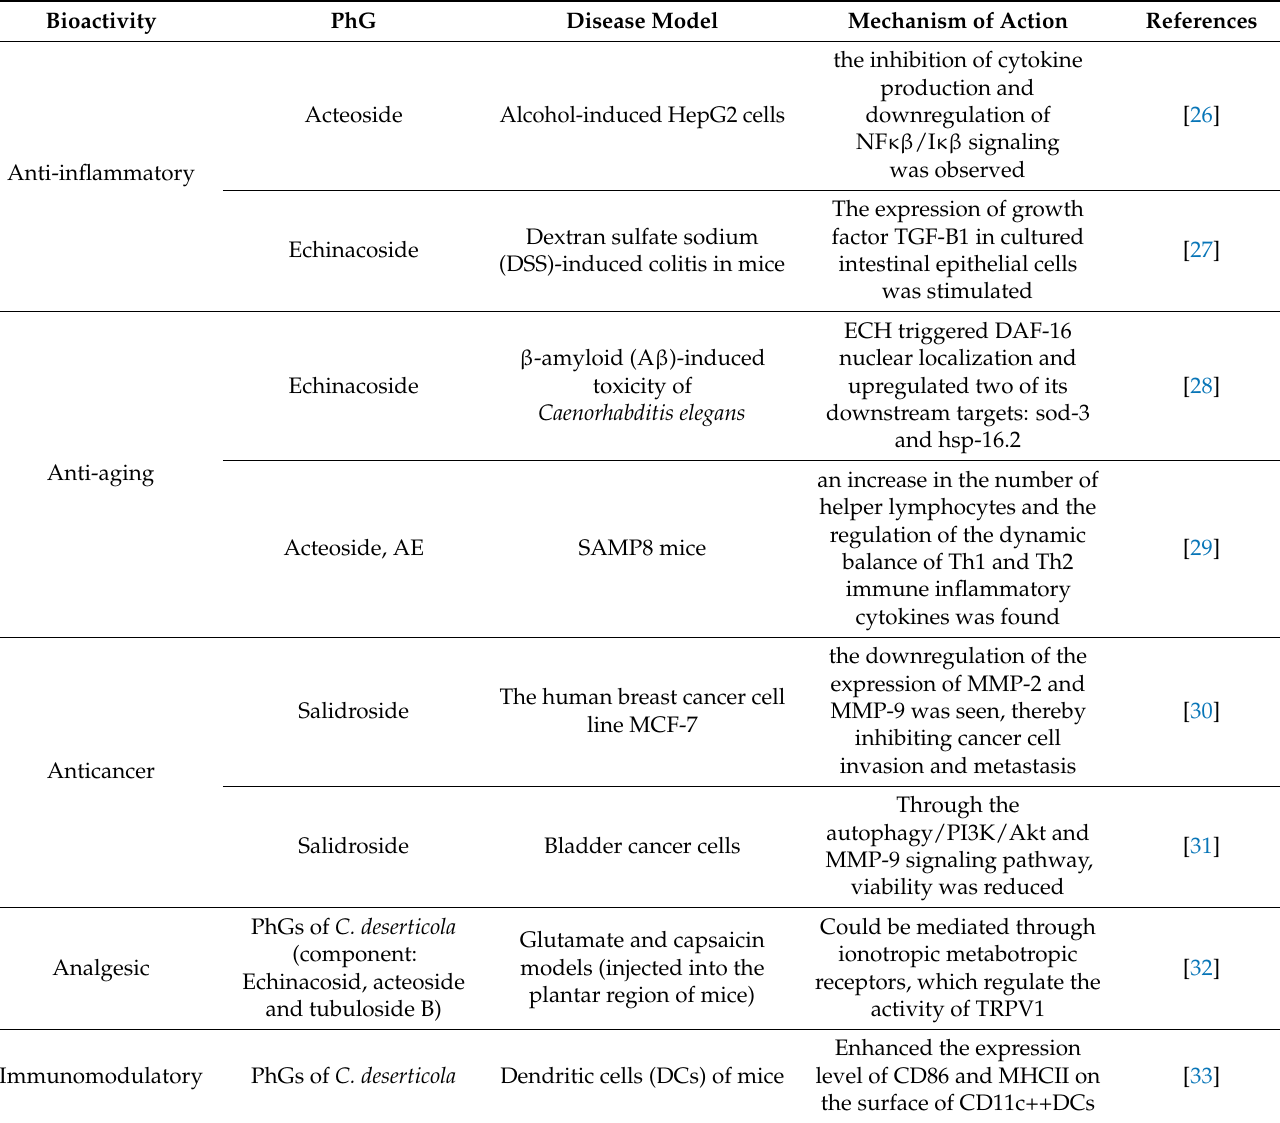
Table 1. Research status of PhG